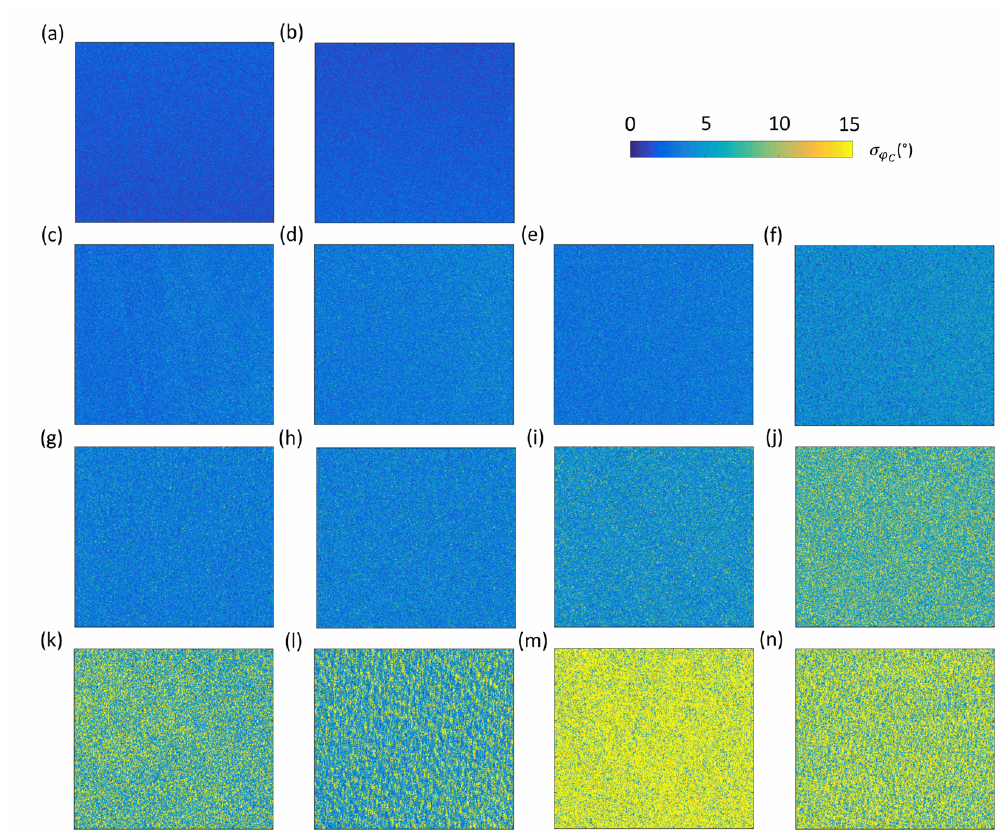
Figure 5. σ ϕ ( ◦ ) images evaluated over the ROIs shown in Figure 1. Rows refer to the different C SAR sensors: ( a , b ) UAVSAR; ( c – f ) AP; ( g – j ) RS; and ( k – n ) TSX. Columns are organized